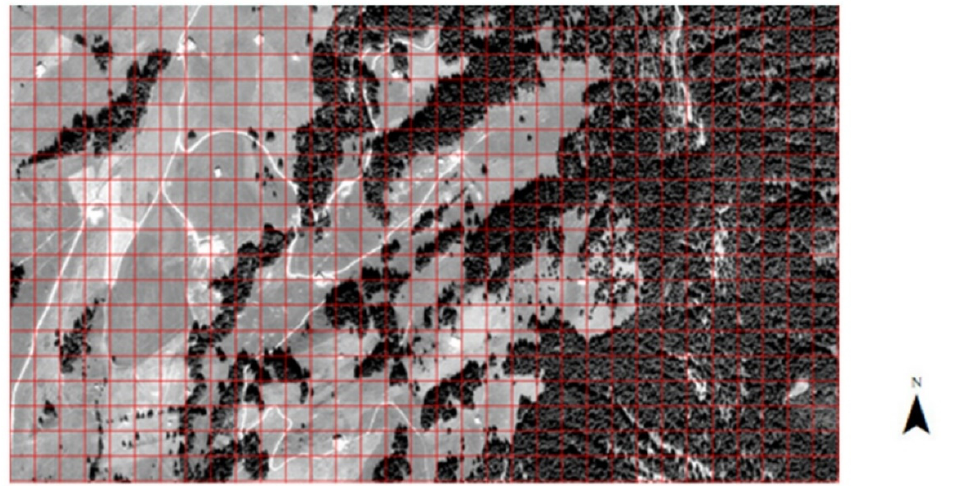
Figure 4. Subset of the aerial image of study area 1 with a regular 50 m grid (red squares); grid cells were used as image patches for all processing steps.